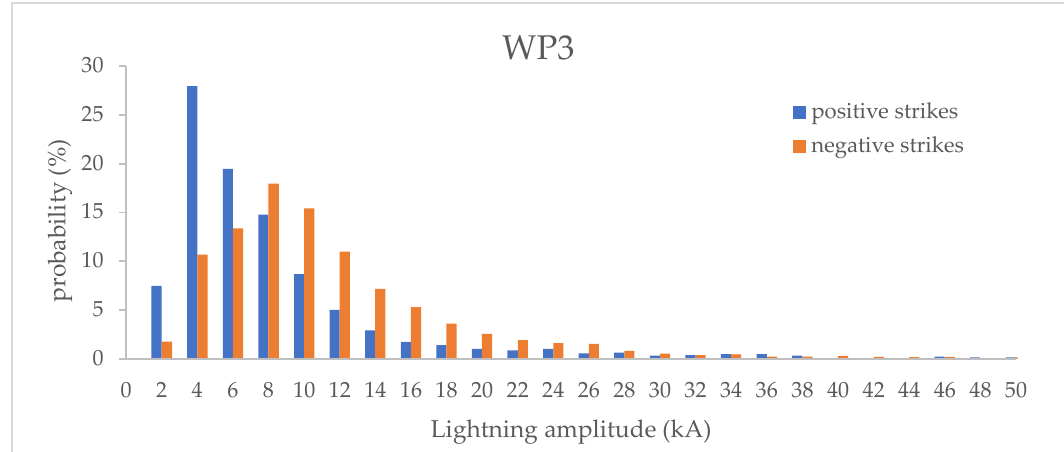
Figure A3. Lightning current amplitude probability distributions for positive and negative strikes extracted from the rec- orded incidents throughout the period 2011–2020 for WP3.